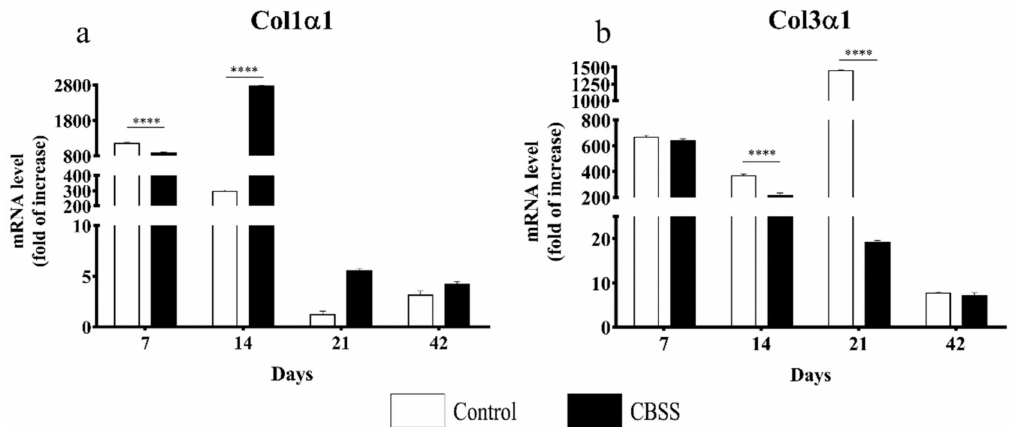
Figure 9. Gene expression analysis for collagen genes involved in skin wound healing. ( a ) Relative expression of the collagen type I (Col1 α 1) gene and ( b ) collagen type III (Col3 α 1) gene at 7, 14, 21, and 42 days after wounding in control and CBSS-treated wounds. Data are shown as mean ± SEM. Unwounded skin was used as the calibrator sample. Statistical differences were measured between the two experimental groups at the same time point. **** p < 0.0001.